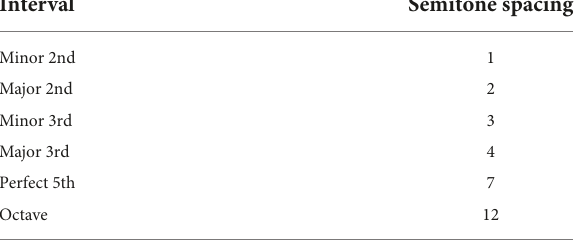
TABLE 2 Interval notation with the corresponding semitone spacing between